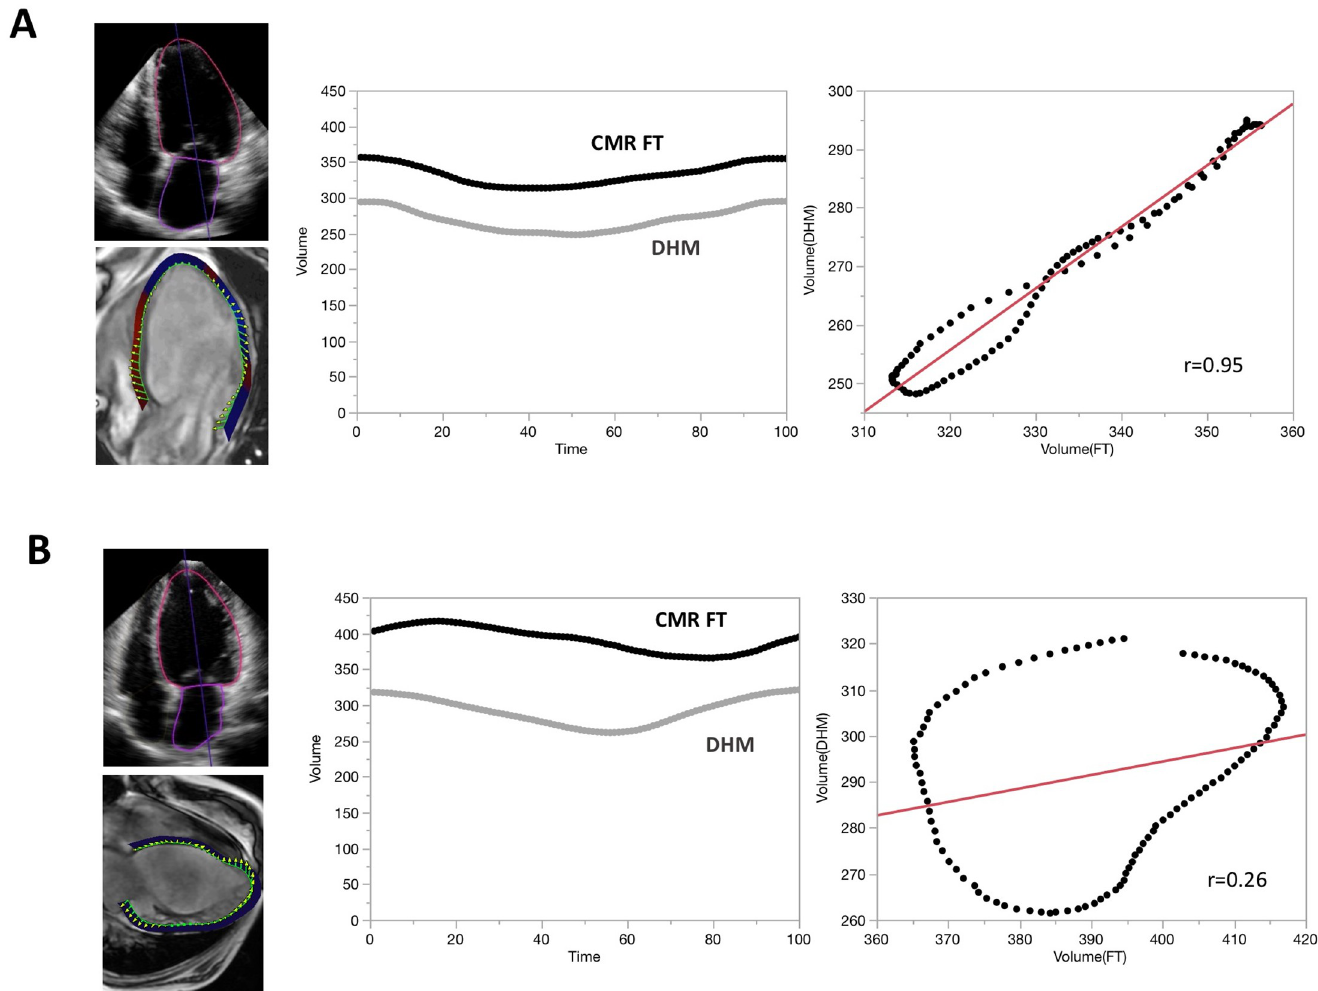
Fig 7. Representative cases for left ventricular (LV) volume curves generated by fully automated quantification software and cardiac magnetic resonance (CMR) feature tracking method. A: A case of good correlation. Left upper panel shows apical 4-chamber view of Dynamic HeartModel and left lower panel shows apical 4-chamber view of CMR feature tracking. Middle panel shows LV volume curves by both methods. Right panel shows their correlation. From LV volume curves during one cardiac cycle, we extracted 100 data points using interpolation and digitalization of the curve. B: A case of poor correlation. Note timing of maximum and minimum LV volume is